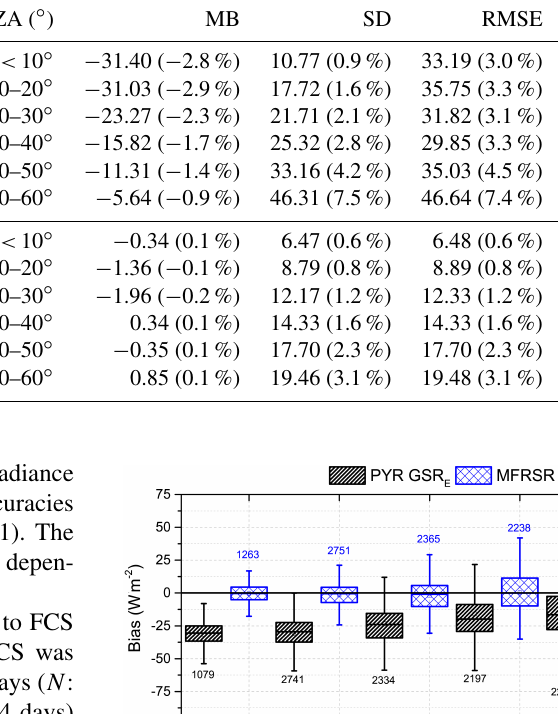
Table 4. Statistics for the bias between instantaneous GSR E performed with PYR and MFRSR with respect to BSRN GSR E (XXX GSR E – BSRN GSR E ) at IZO between May and June 2015 (27 cloud-free days) (in Wm − 2 ) for different range of SZA. MB, median bias; SD, standard deviation; and RMSE, root mean square error. Statistics for the relative bias are in parentheses.